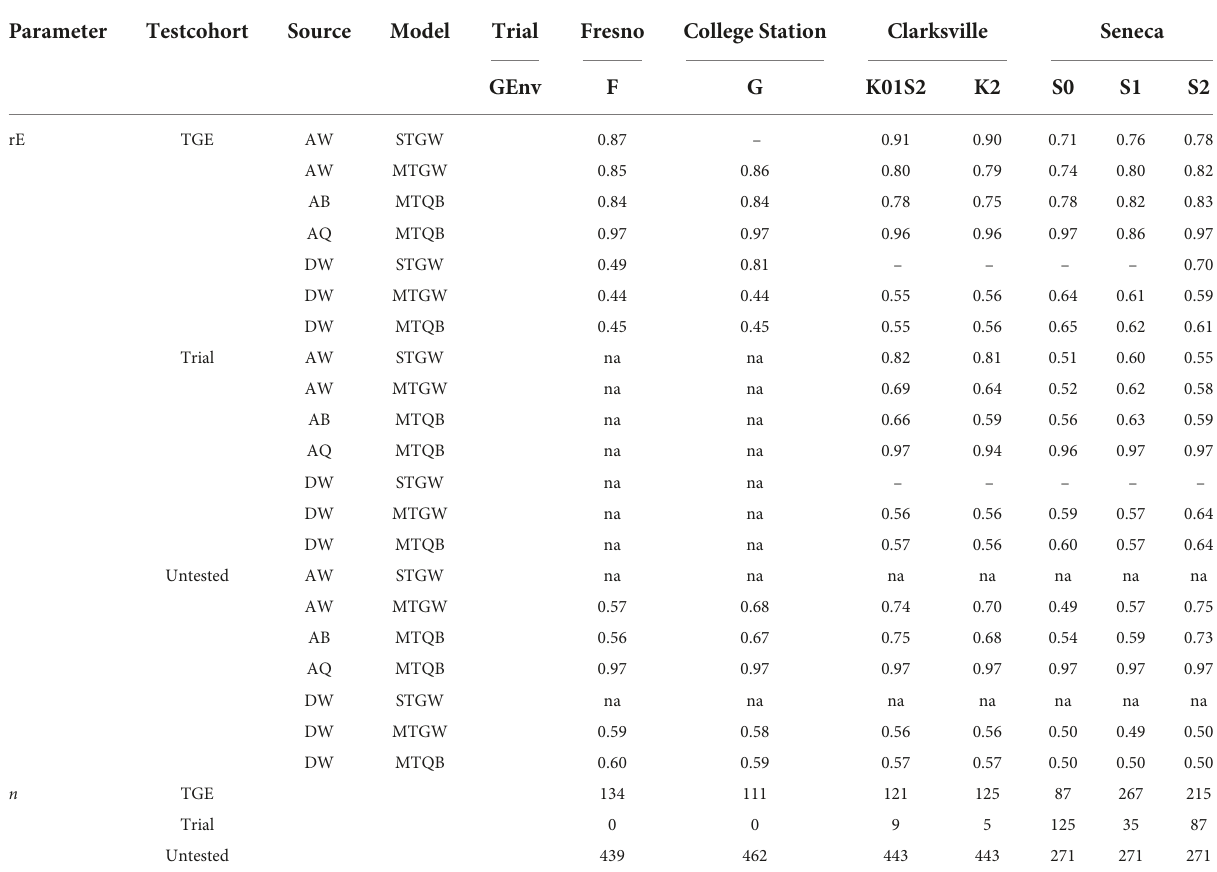
TABLE 4 Expected peach/nectarine SSC prediction accuracy (rE) of additive (A) and dominance (D) genomic effects for most parsimonious single-trial genome-wide (STGW), multi-trial genome-wide (MTGW), and multi-trial QTL + background genome (MTQB) multivariate models, and the number of individuals (n), by genomic environment (GEnv, for details, see Figure 2 ), within the trial for three test cohorts (TGE tested, individuals tested in the corresponding genomic environment within a trial; Trial tested, individuals tested in a different genomic environment at the corresponding trial; Trial untested, individuals not tested in the corresponding trial).